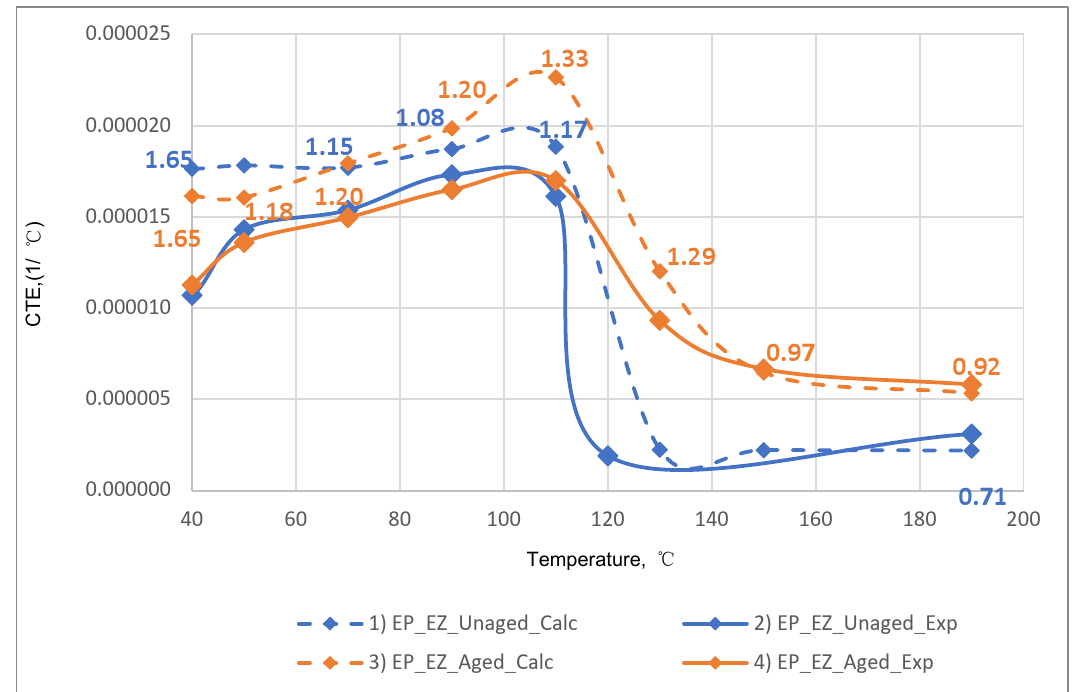
Figure 18. Dependence plotted against averaged CTE values on temperature for epoxy fiberglass on glass fabric EZ-200: (1) calculated for EP-EZ200; (2) experimental for EP-EZ200; (3) calculated for EP-EZ200-TA; (4) experimental for EP-EZ200-TA.